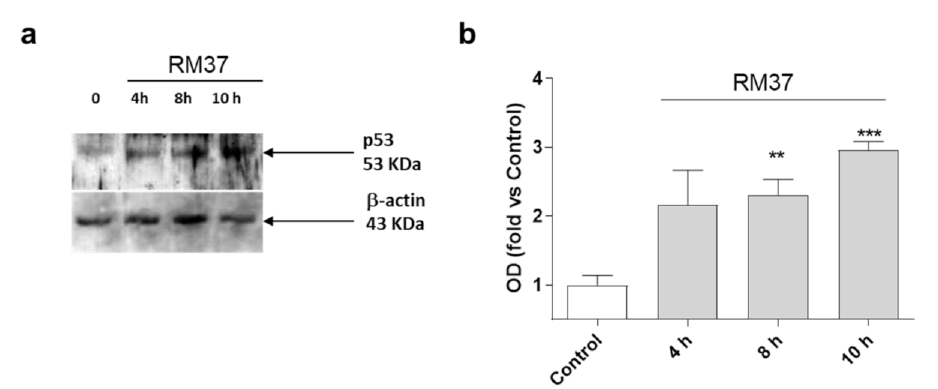
Figure 5. p53 protein accumulation in U343MG cells. U343MG cells were challenged with DMSO (control) or 20 µ M RM37 for 4h, 8h, or 10h. Lysates were subjected to Western blot analysis using an antibody specific for p53. One representative Western blot is shown ( a ). Full screen of Western blot assay was provided in a separate file. Quantitative analysis was performed using ImageJ and shown in panel ( b ). Data are expressed as fold of optical density (OD) of the immunoreactive band relative to that of control, set to 1, and are mean values ± SEM of three different experiments. ** p < 0.01, *** p < 0.001 versus control.